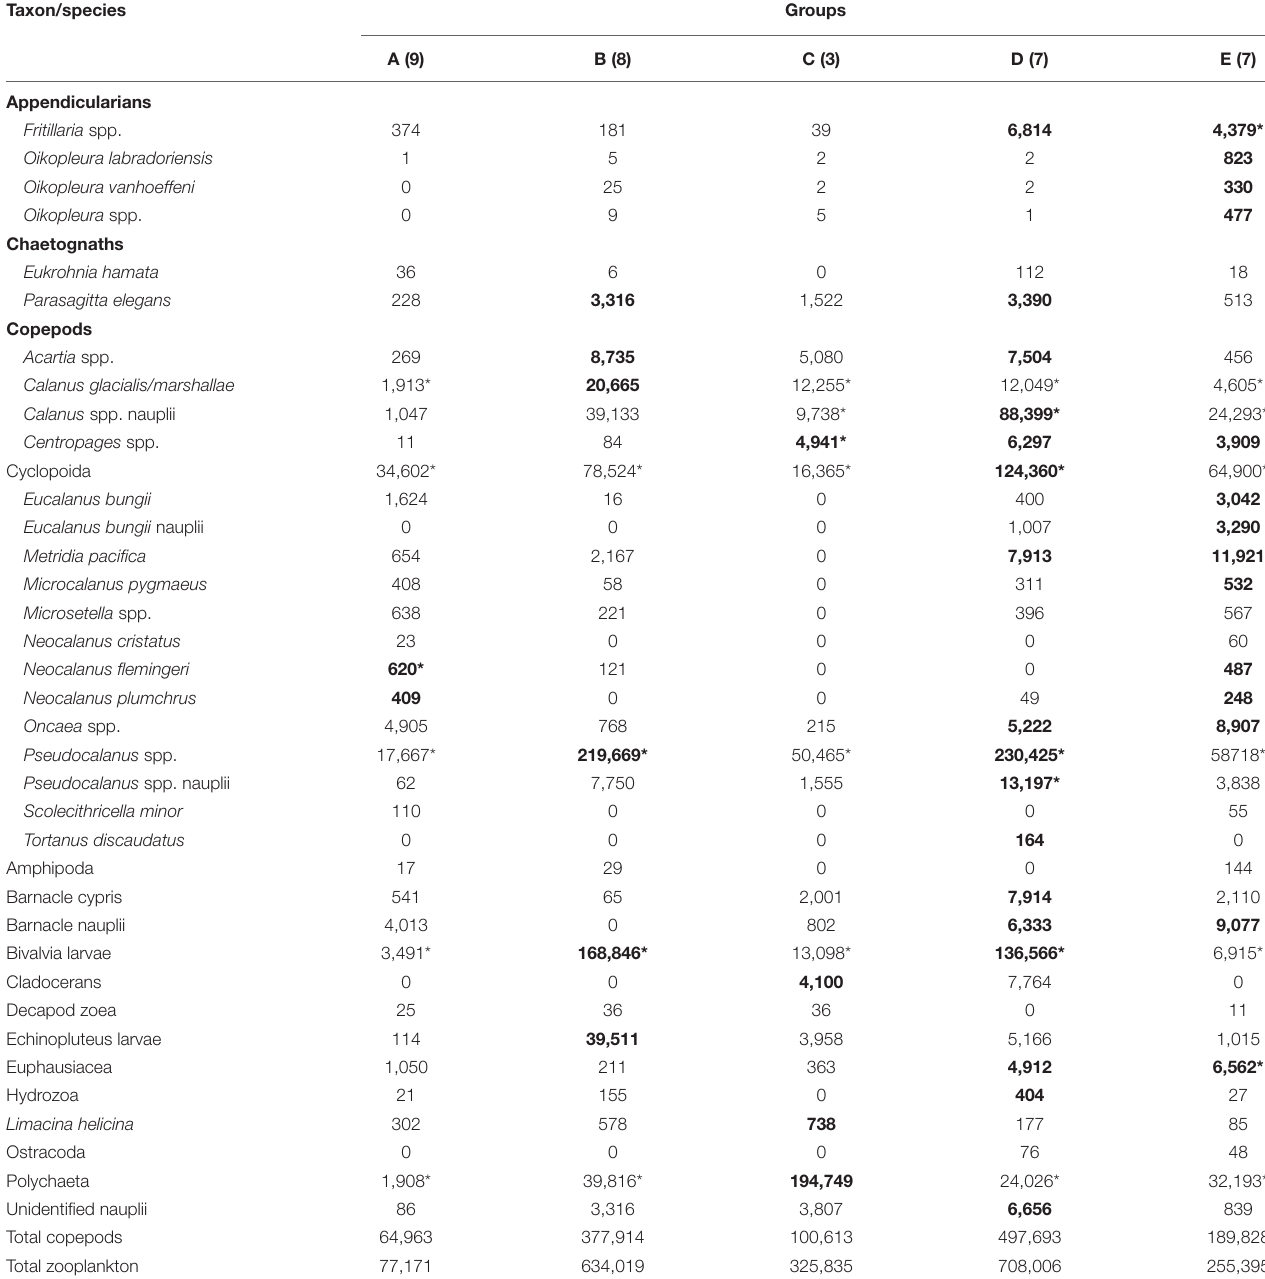
TABLE 2 | Mean abundance (ind. m − 2 ) for all species/taxon of the zooplankton groups identified by cluster analysis (cf. Figure 4 ) in the northern Bering Sea during July of 2017 and